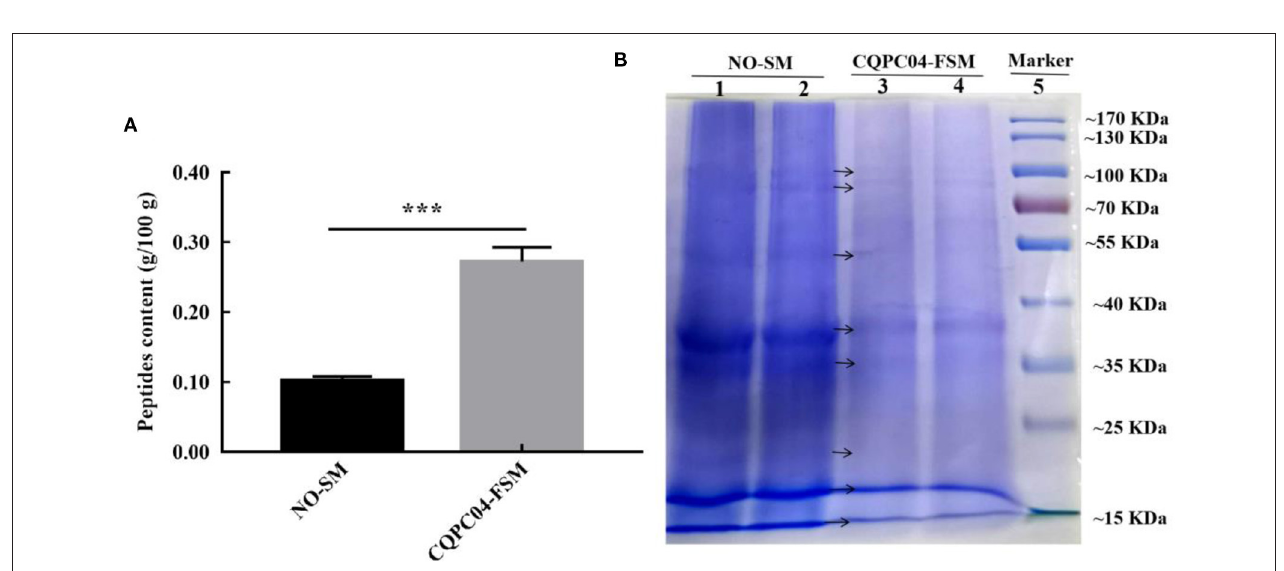
FIGURE 2 | Peptide contents and protein profiles in soy milk before and after fermentation. (A) peptide contents in non-fermented and L. fermentum CQPC04-fermented soy milk; (B) protein profiles of non-fermented and L. fermentum CQPC04-fermented soy milk. NO-SM: non-fermented soy milk; CQPC04-FSM: L. fermentum CQPC04-fermented soy milk. *** p < 0.001 compared to D-gal